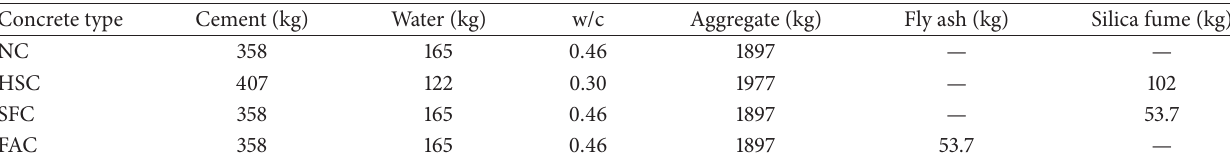
Table 2: Concrete mix design for 1m 3 .